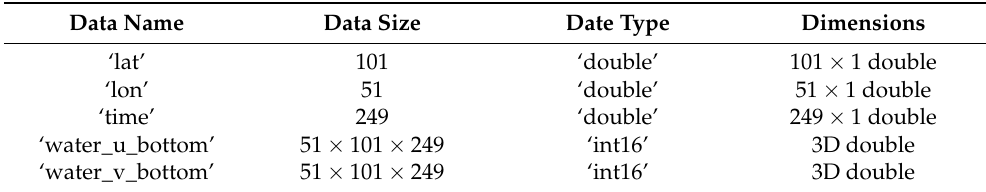
Figure 2. The tide table. Table 1. The current